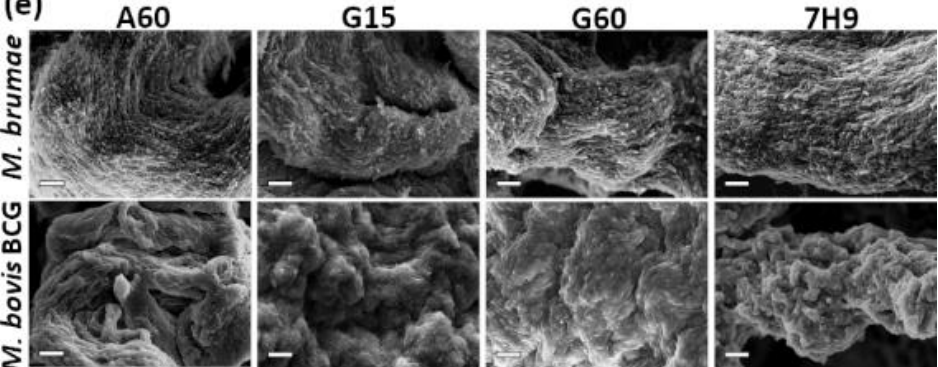
Figure 3. Characteristics of mycobacteria grown in optimized Sauton media. ( a ) Biomass production and ( b ) length of M. brumae and Mycobacterium bovis bacillus Calmette–Guérin (BCG) cells in each culture medium. Length is expressed in micrometres (μm). Data represent the mean ± SD in each medium from at least three independent experiments. ** p < 0.01, *** p < 0.001 (ANOVA test). ( c ) Macroscopic appearance and ( d,e ) representative SEM micrographs of M. brumae and M. bovis BCG pellicles in each culture medium. The bar size is 30 µ m in ( d ) and 6 µ m in ( e